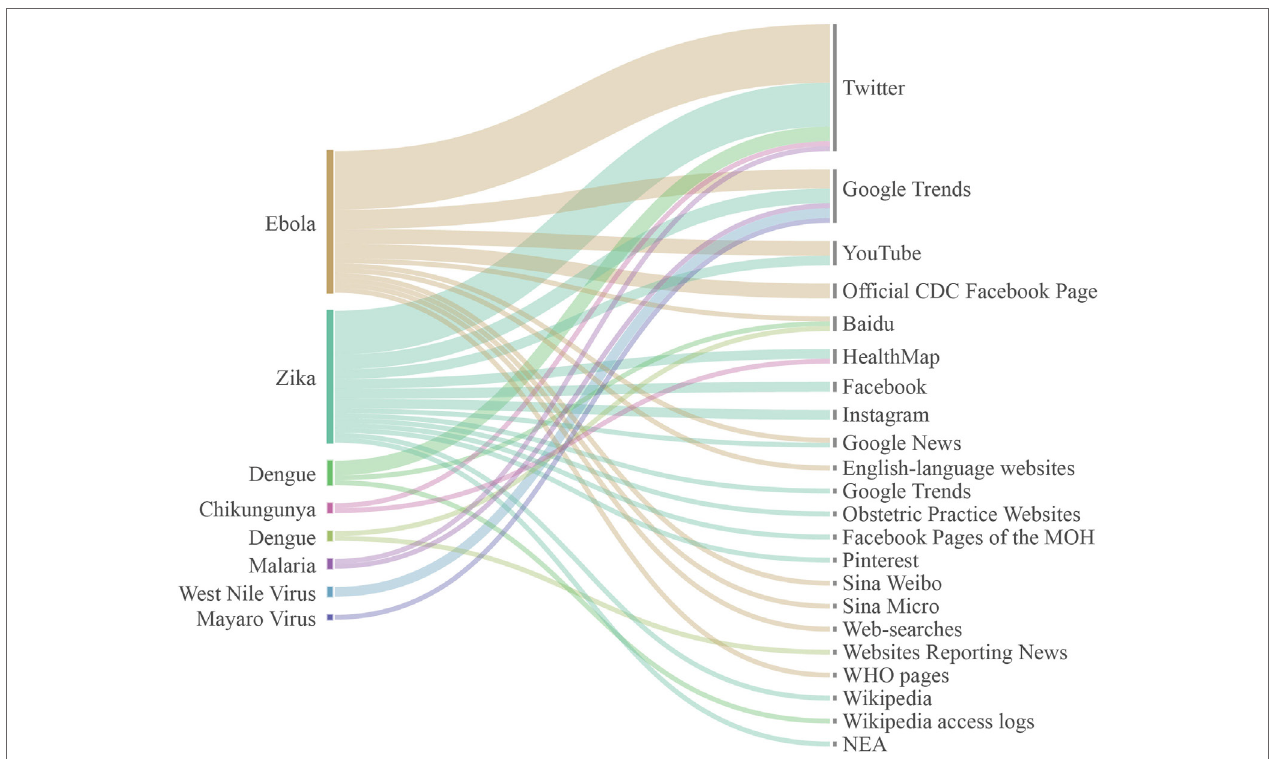
FigURe 3 | Communicable tropical/sub-tropical disorders and neglected tropical diseases investigated and non conventional sources analyzed, according to our results. Line thicknesses represent the volume of studies